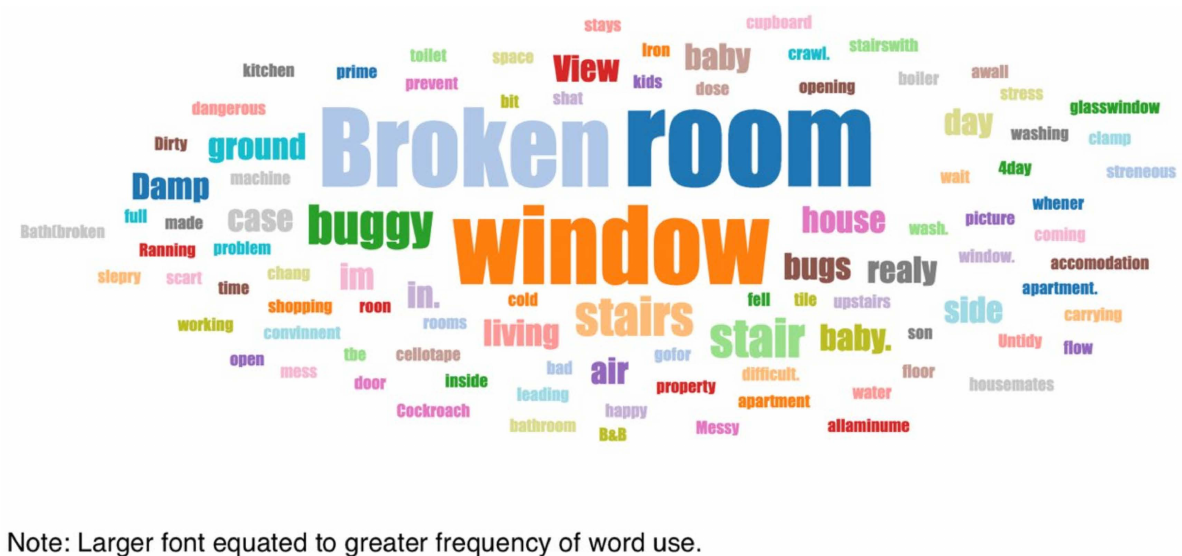
Figure 6. Word cloud of optional accommodation